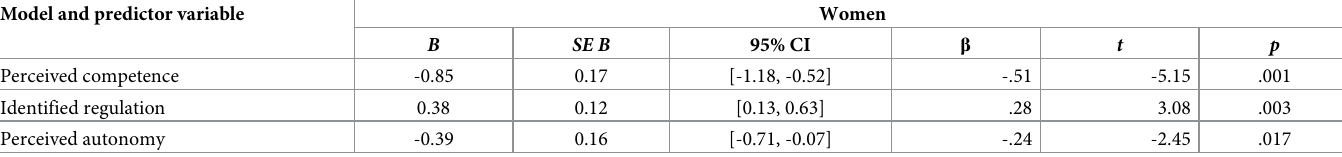
CI = confidence interval for B . Models based on backward